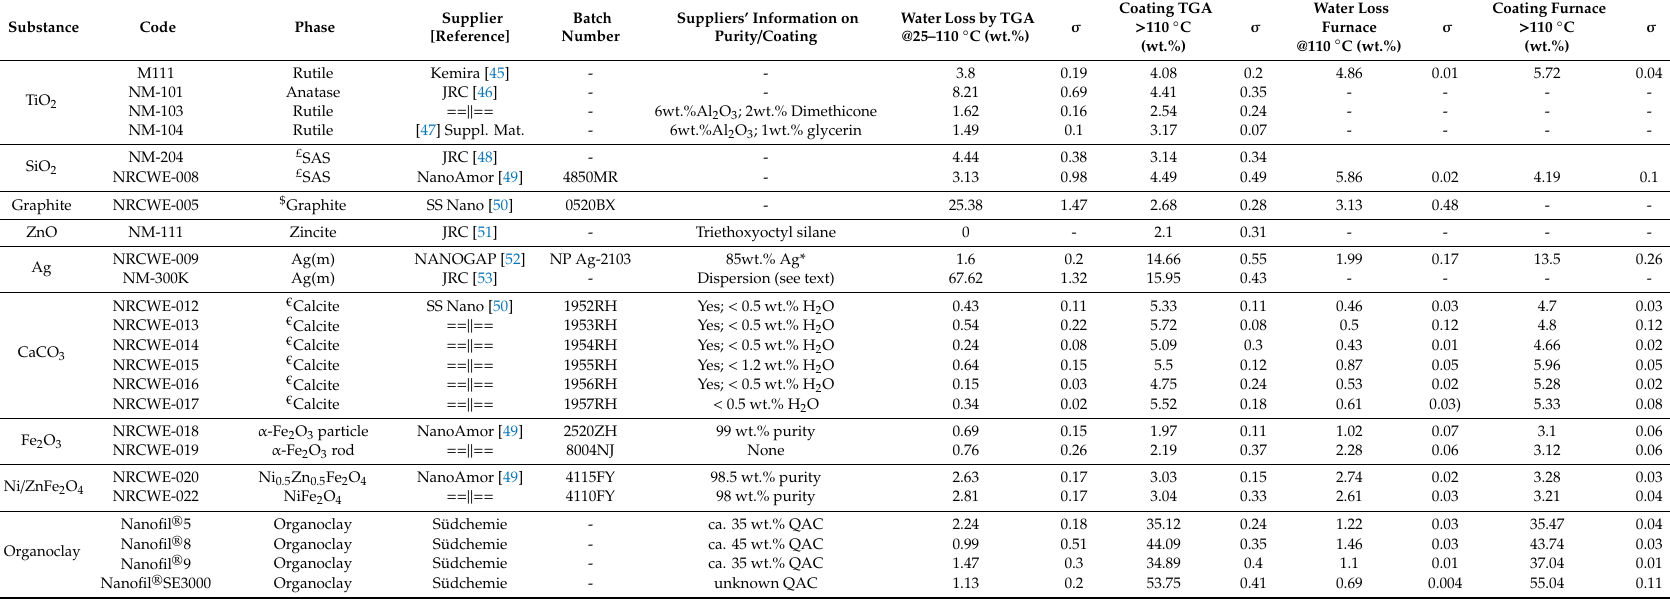
Table 2. Available information on the MNMs, and measured water content and maximum amount of possible organic coating of the MNMs (mass loss before any decomposition of the inorganic core) by two di ff erent methods: TGA and the laboratory furnace method. The loss is %-w / w and the uncertainty is indicated by the standard error of mean ( σ